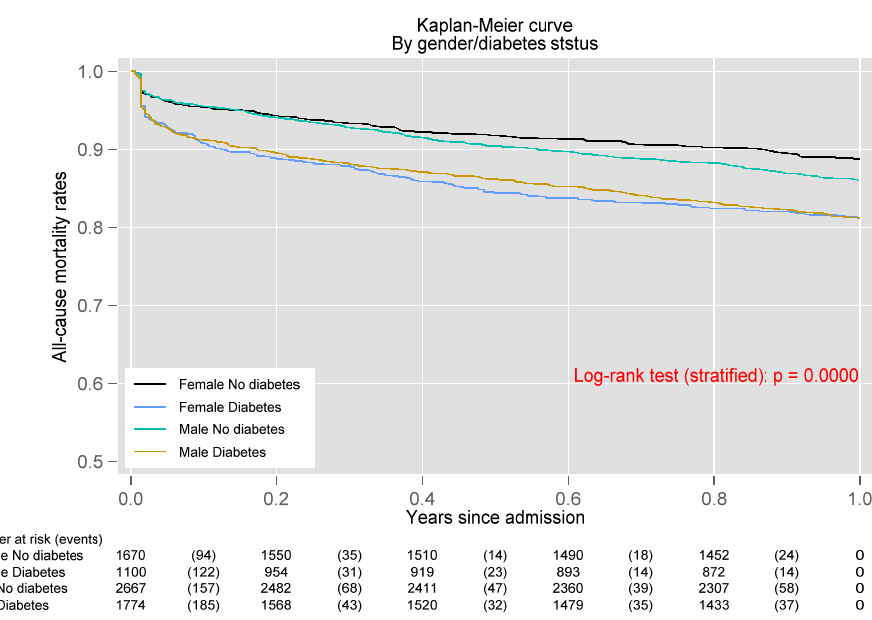
Figure 1. Kaplan–Meier curves for one-year mortality after stratifying patient population according to sex and Diabetes mellitus.